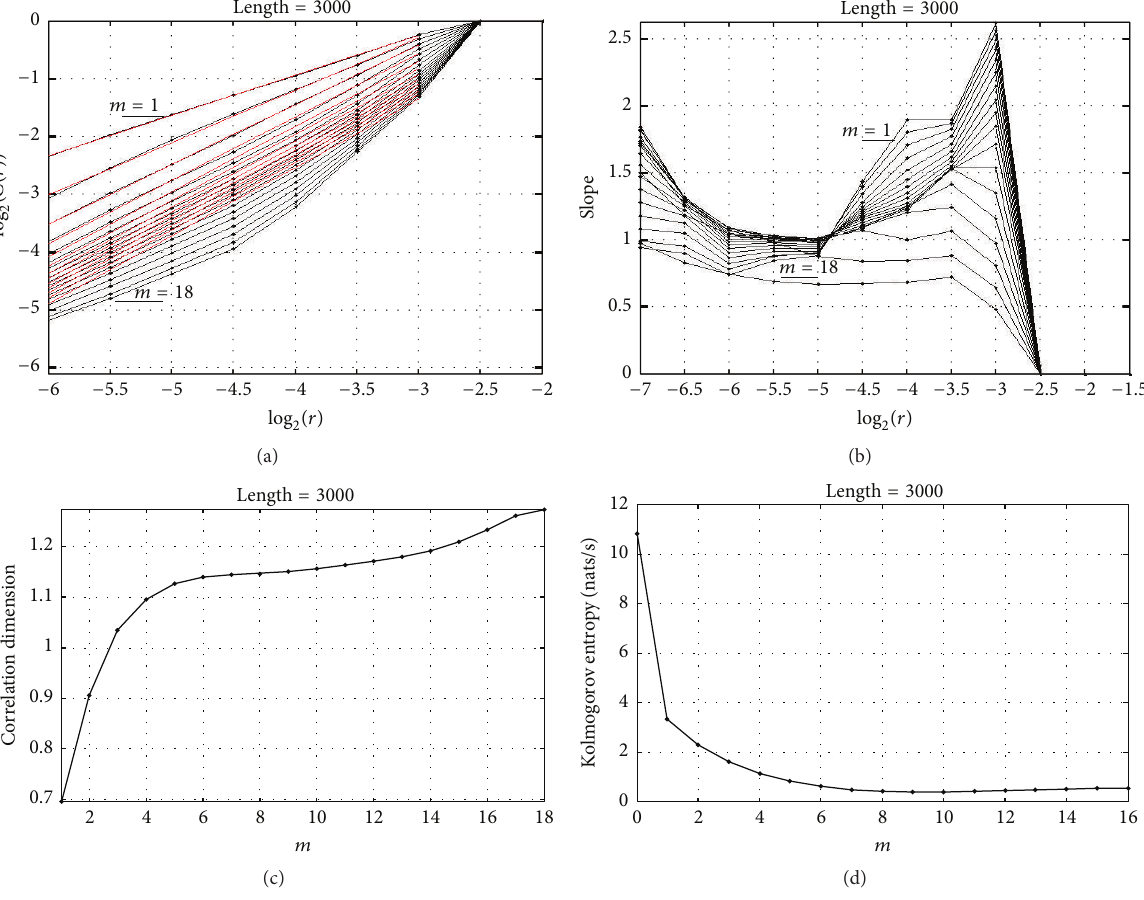
Figure 4: At 𝑁 = 3000 . (a) Correlation integral curve. Points pertaining to the same value of 𝑚 are connected by lines. The values of 𝑚 are 𝑚 = 1 (top curve), 4, 6, .. ., 18 (bottom curve); (b) slope curve of the time serials. An ordinate value is the slope of log 𝐶(𝑟,𝑚) and log 𝑟 ; (c) correlation exponent curve 𝐷 2 = 1.1466 ; (d) the Kolmogorov entropy of system (15) attractor is equal to 𝐷 2 = 0.3096 .